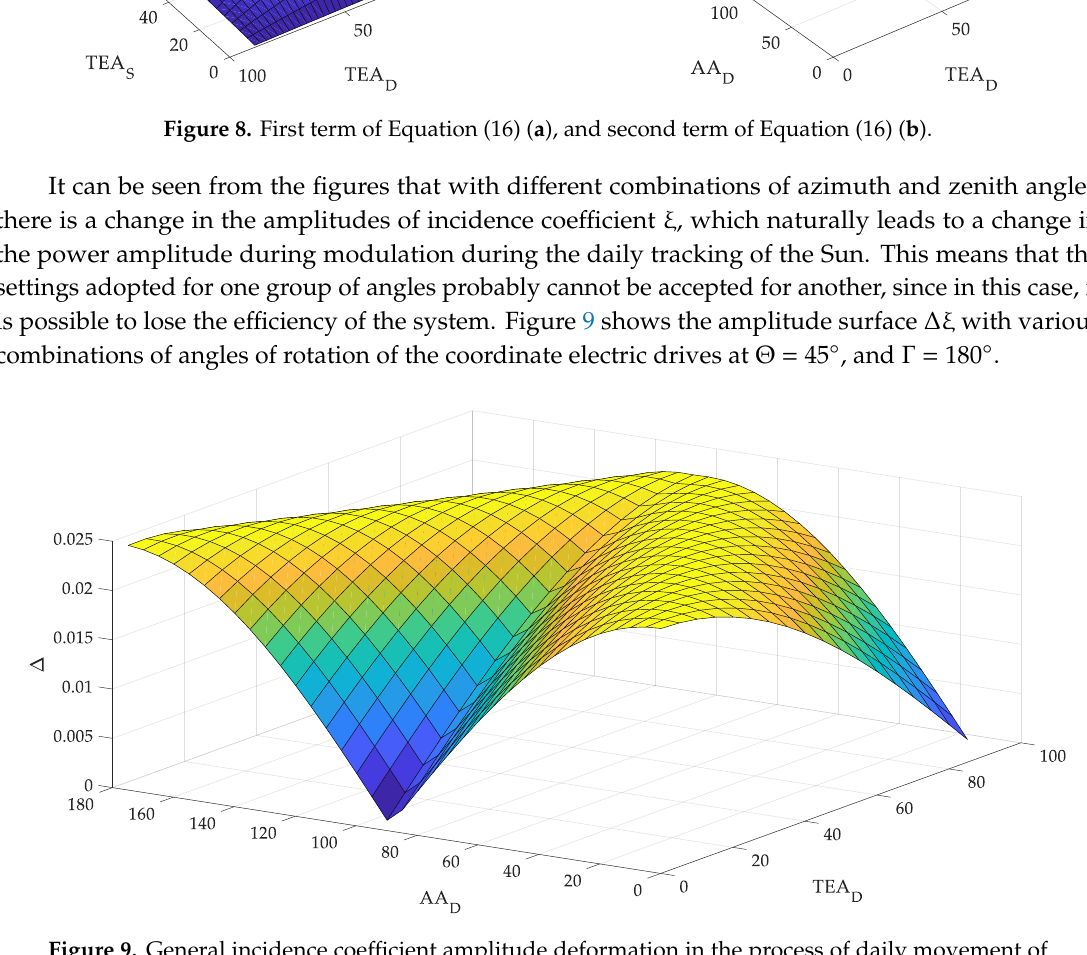
Figure 9. General incidence coefficient amplitude deformation in the process of daily movement of the Sun .